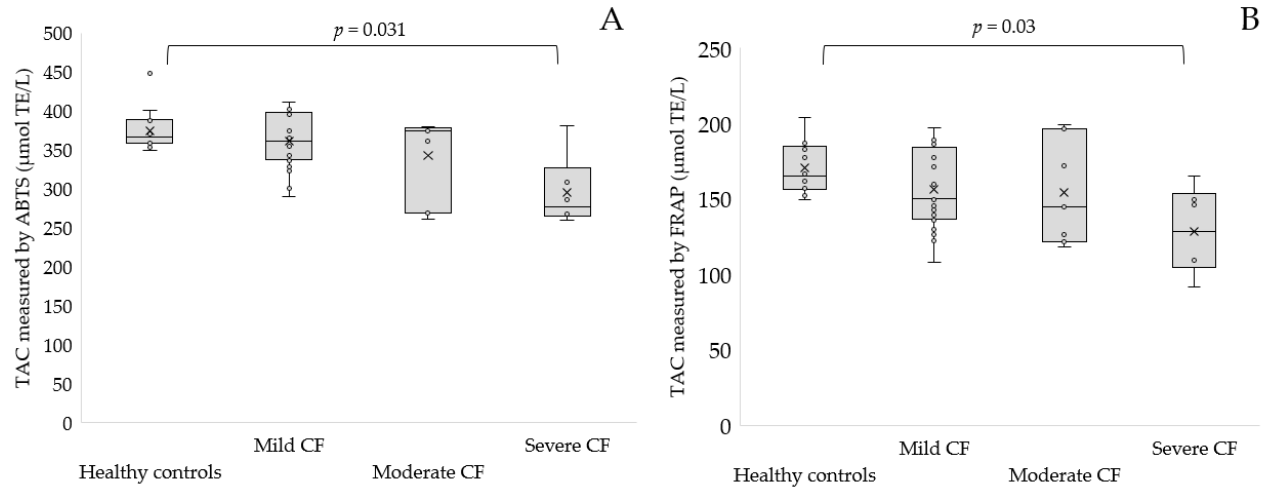
Figure 5. TAC level measured by ABTS • ( A ) and TAC measured by FRAP ( B ) in the serum of patients with mild, moderate and severe CF as compared to the control group.